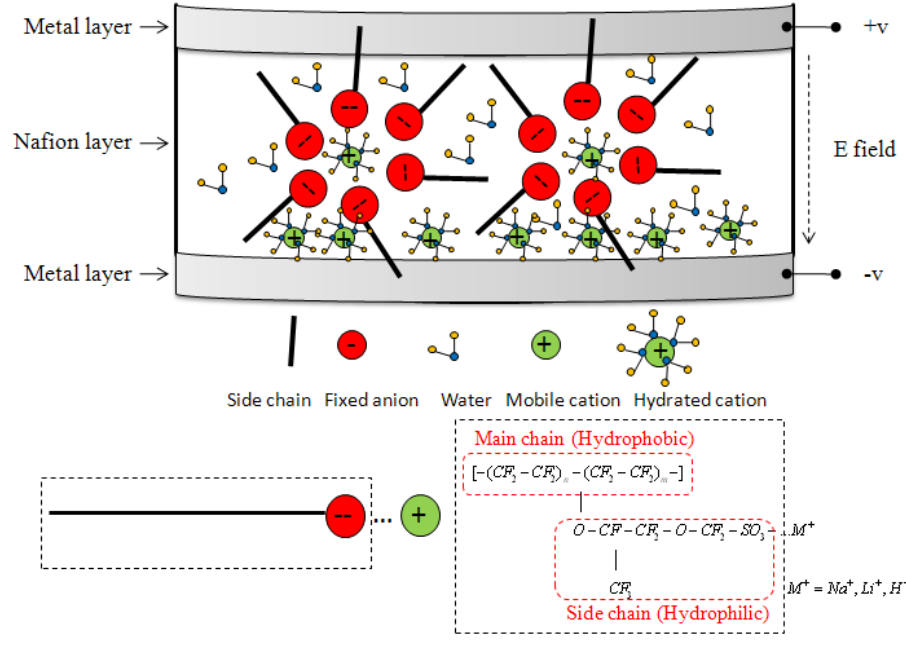
Figure 1. Schematics of the electro-osmotic migration of hydrated counter-ions within the IPMC network. Black bars and red balls stand for hydrophilic side chains and hydrophobic main chains,